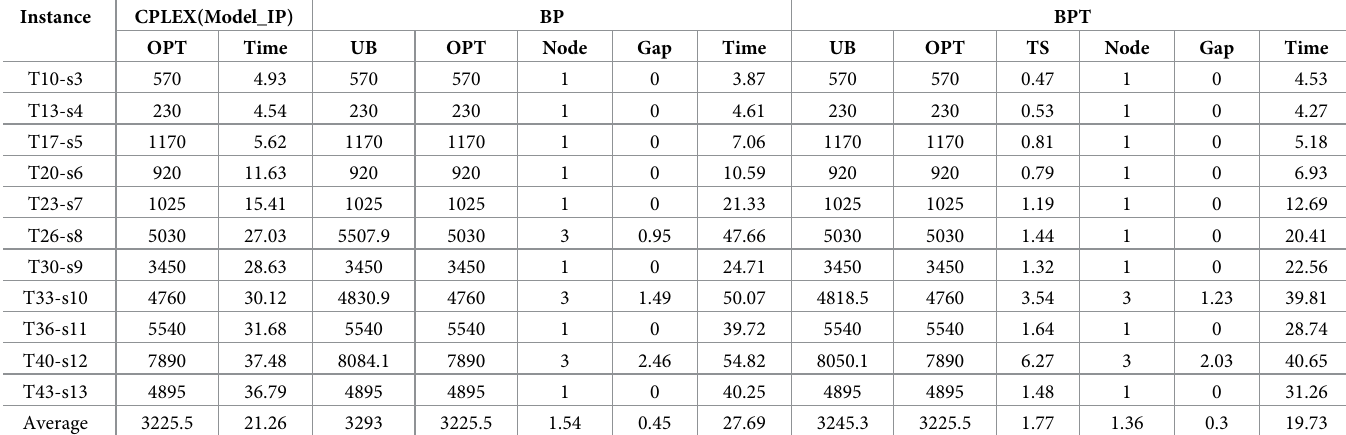
Table 5. Computational results for small-sized